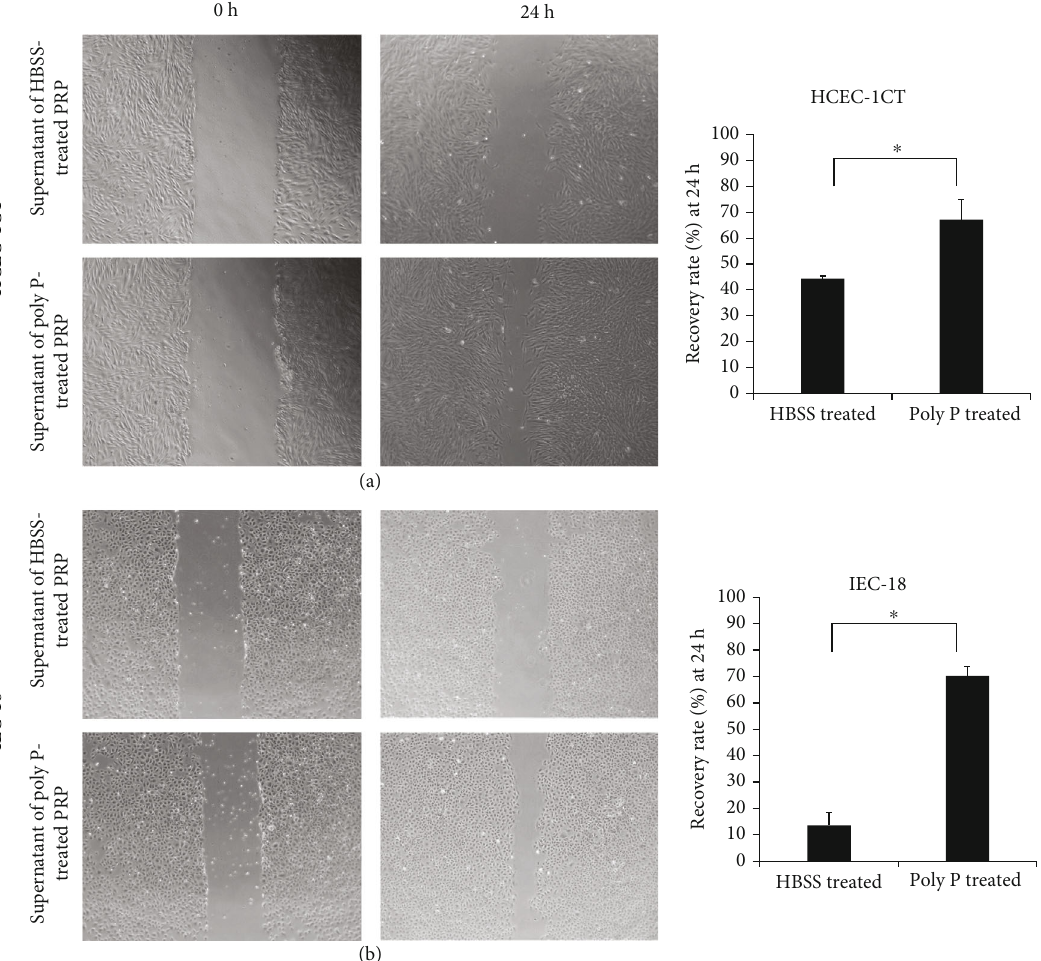
Figure 3: The supernatant of poly P-treated PRP increased the wound healing e ff ect in epithelial cells. A cell scratch assay showed that the supernatant of poly P-treated PRP accelerated the closure of wound in HCEC-1CT (a) and IEC-18 (b) cells. The error bars and numbers show the standard deviation. ∗ P < 0 : 05 by Student ’ s t rat PRP in IEC-18 cells (Figure 5(a)). The epithelial healing e ff ect of the supernatant of poly P-treated rat PRP was atten- uated by treatment with an ERK inhibitor (FR180204) but not inhibitors of p38 (SB 203580), PI3K/Akt (LY294002), or JNK (SP600125) (Figures 5(b) – 5(e)), suggesting that ERK signaling is responsible for promoting wound healing.